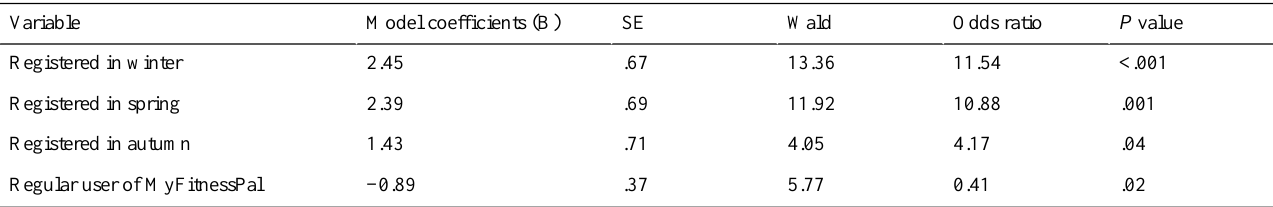
P valueOdds ratioWaldSEModel coefficients (B)Variable